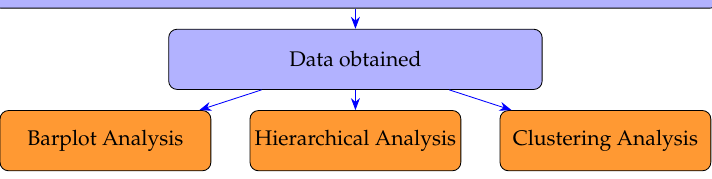
Figure 1. Research flow chart.